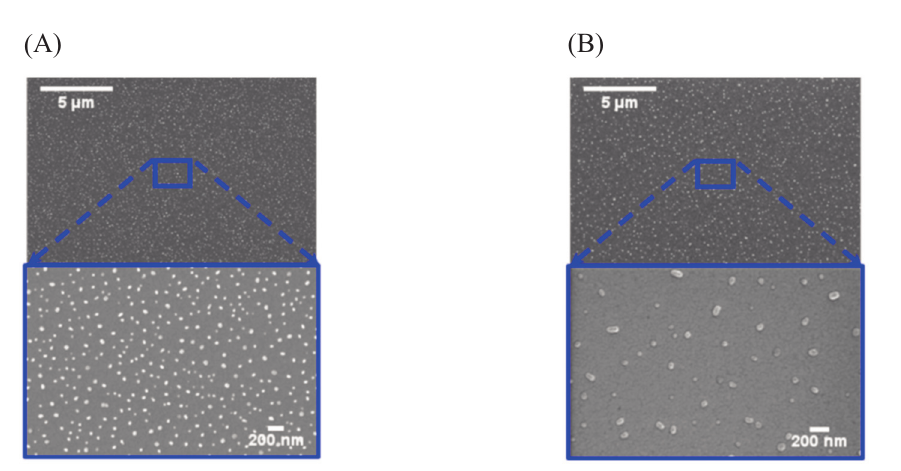
Fig. 2. High­resolution SEM microscopy image of the blank coverslip before (A) and after (B) the thin film deposition of 1.5nm Ti (adhesion layer) and 35nm Au using HR­SEM Zeiss Merlin equipped with an In­Lens SE detector for topographic imaging and In­ Lens energy selective backscattered detector for compositional contrast. Measurements were taken at the operating voltage of 2